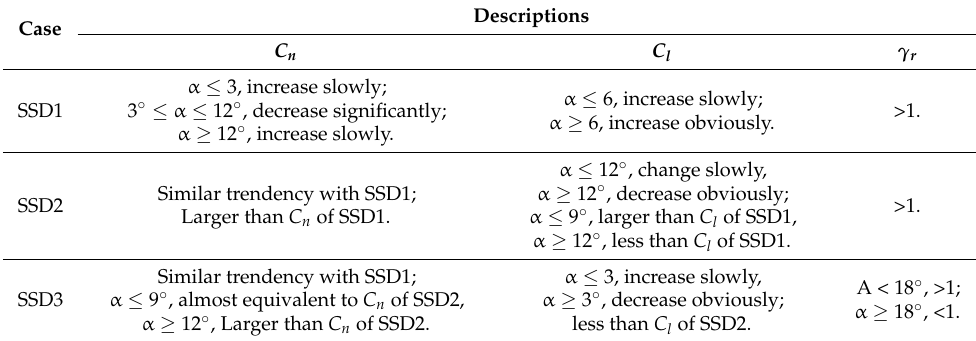
Figure 8. Control characteristics when the three SSDs unfold by 45° alone for Ma = 0.2, Re = 3.98 × 10 7 : ( a ) Pitching moment; ( b ) Rolling and yawing moments. Table 3. Descriptions of control characteristics for the three SSDs.